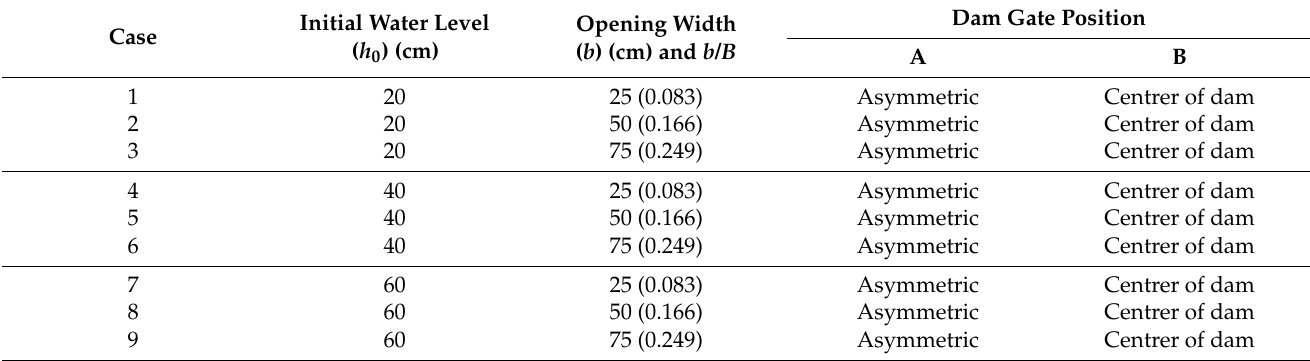
Table 3. Case study.